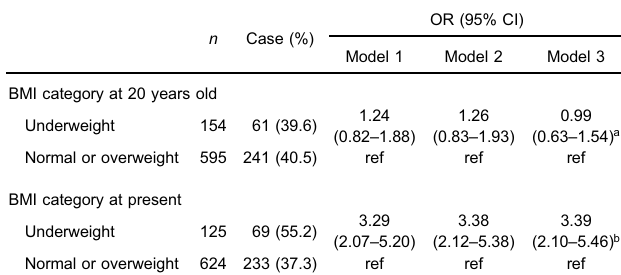
Table 2. Multivariate-adjusted odds ratios of underweight for osteopenia according to BMI at 20 years old and